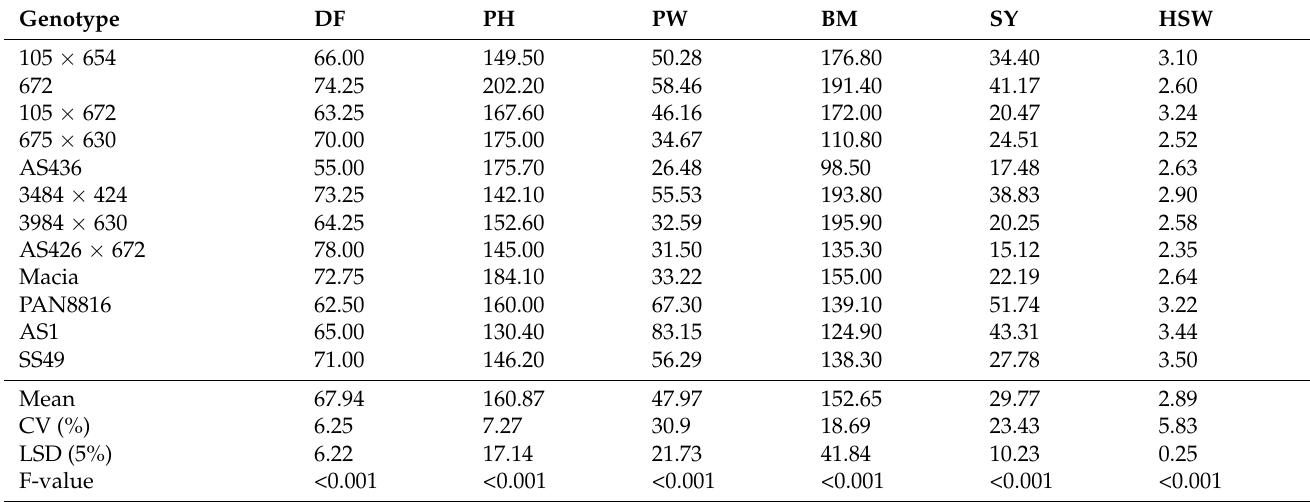
Table 2. Mean values for agronomic traits amongst 12 elite sorghum genotypes evaluated in this study.